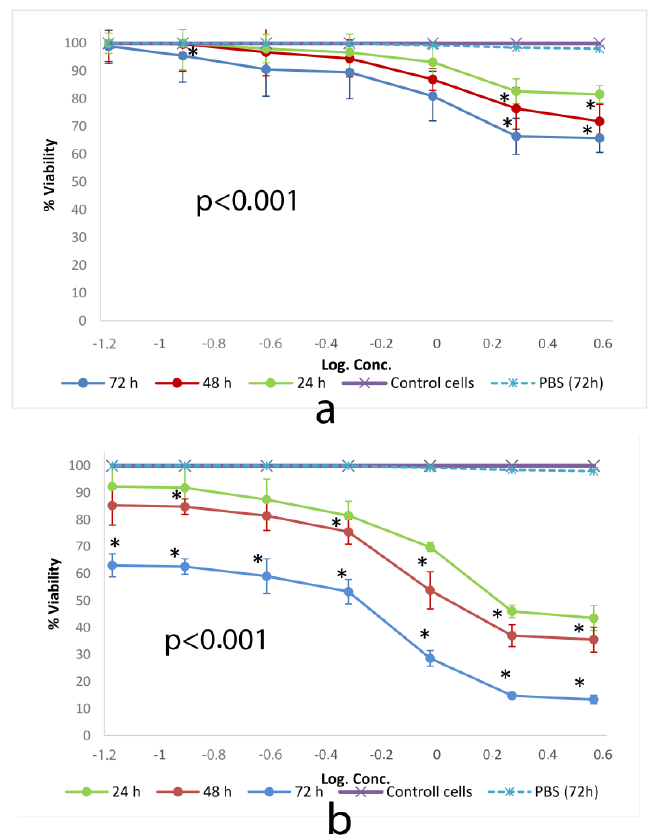
Figure 4. Cytotoxic effect of ( a ) SSM and ( b ) PM at 24, 48 and 72 h on L-929 cell lines determined by WST-1. Data are representative of tree independent trials and are expressed as the mean ± SD. Significant differences between cell viabilities at 24, 48 and 72 h were indicated by * p < 0.05.